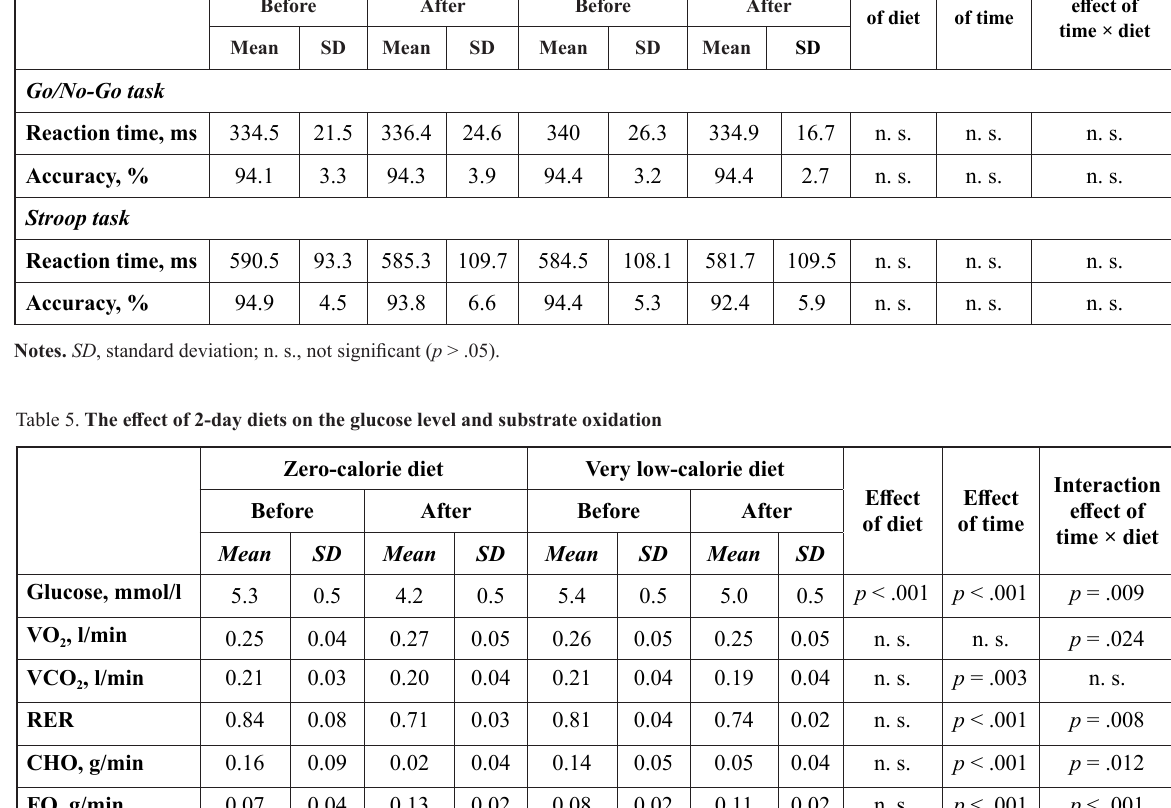
consumption ( F 1,17 = 22.19, p < .001, SP = 0.99, �� ŋ desire to eat sweet ( F 1,17 = 9.19, p = .008, SP = 0.82, ŋ = 0.40), and savory foods ( F 1,17 = 18.26, p = .001, SP = 0.98, = 0.52). The significant time × diet interaction was observed only for fullness ( F 1,17 = 5.49, p = .032, SP = 0.60, ŋ � The zero-calorie diet and very low-calorie diet significantly decreased sensation of fullness ( p < .003) 3.2 ± 2.2 and 1.4 ± 1.7 of initial sensation, respectively. Greater decrement for fullness ( p = .002) was observed after zero-calorie diet when compared to very low-calorie diet. Table 2 Mood states. The mood states of the participants are reported in Table 3. The significant time × diet interaction was observed only for vigor ( F 1,17 = 5.49, p = .038, SP = 0.60, ŋ �� = 0.24). The zero-calorie diet significantly decreased vigor ( p = .040) 1.7 ± 3.2 of initial state, whereas this state remained unchanged during the very low-calorie diet. Greater decrement for vigor ( p = .038) was observed after zero-calorie diet when compared to very low-calorie diet. Table 3 Inhibitory control. Data of inhibitory control requiring tasks are reported in Table 4. There was no significant effect of time and diet, or the time × diet interaction on the inhibitory control.